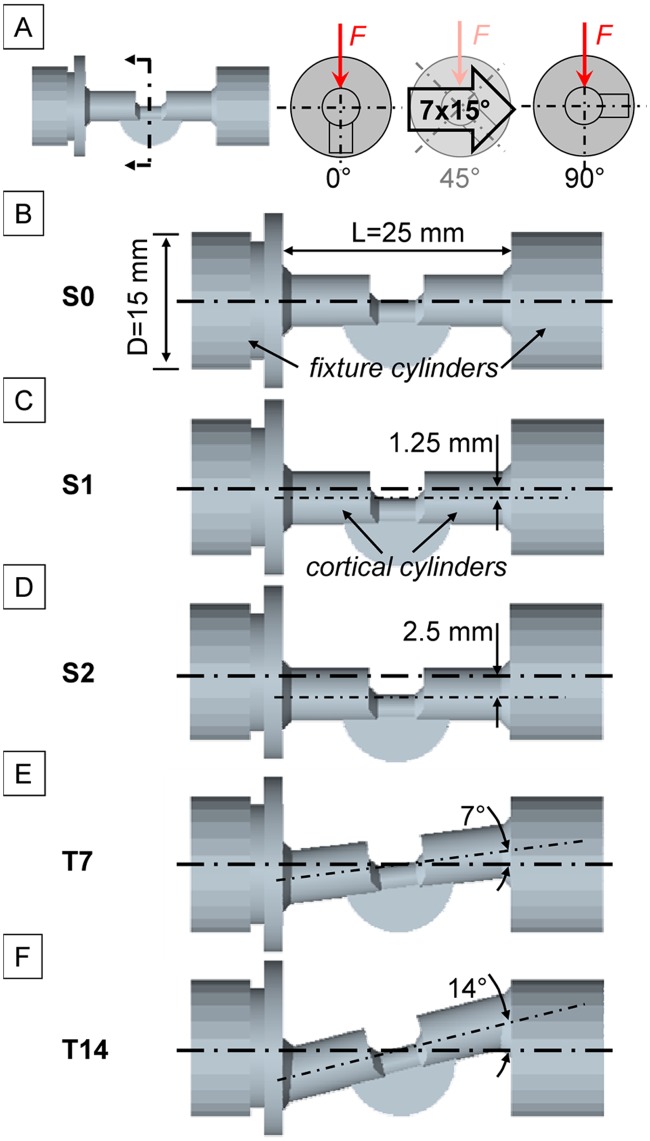
Standardized test specimens representing simplified substitutes for healed rat femurs.A) Variation of the rotational alignment for bending tests in seven increments of 15° between 0°- and 90°-rotational alignment. Model designs showing different relations between the axis of the “fixture cylinders” and the axis of the “cortical cylinders “: B) Design S0 with perfect alignment C) Design S1 with 1.25 mm parallel offset. D) Design S2 with 2.5 mm parallel offset, E) Design T7 with 7° angulation, E) Design T14 with 14° angulation.